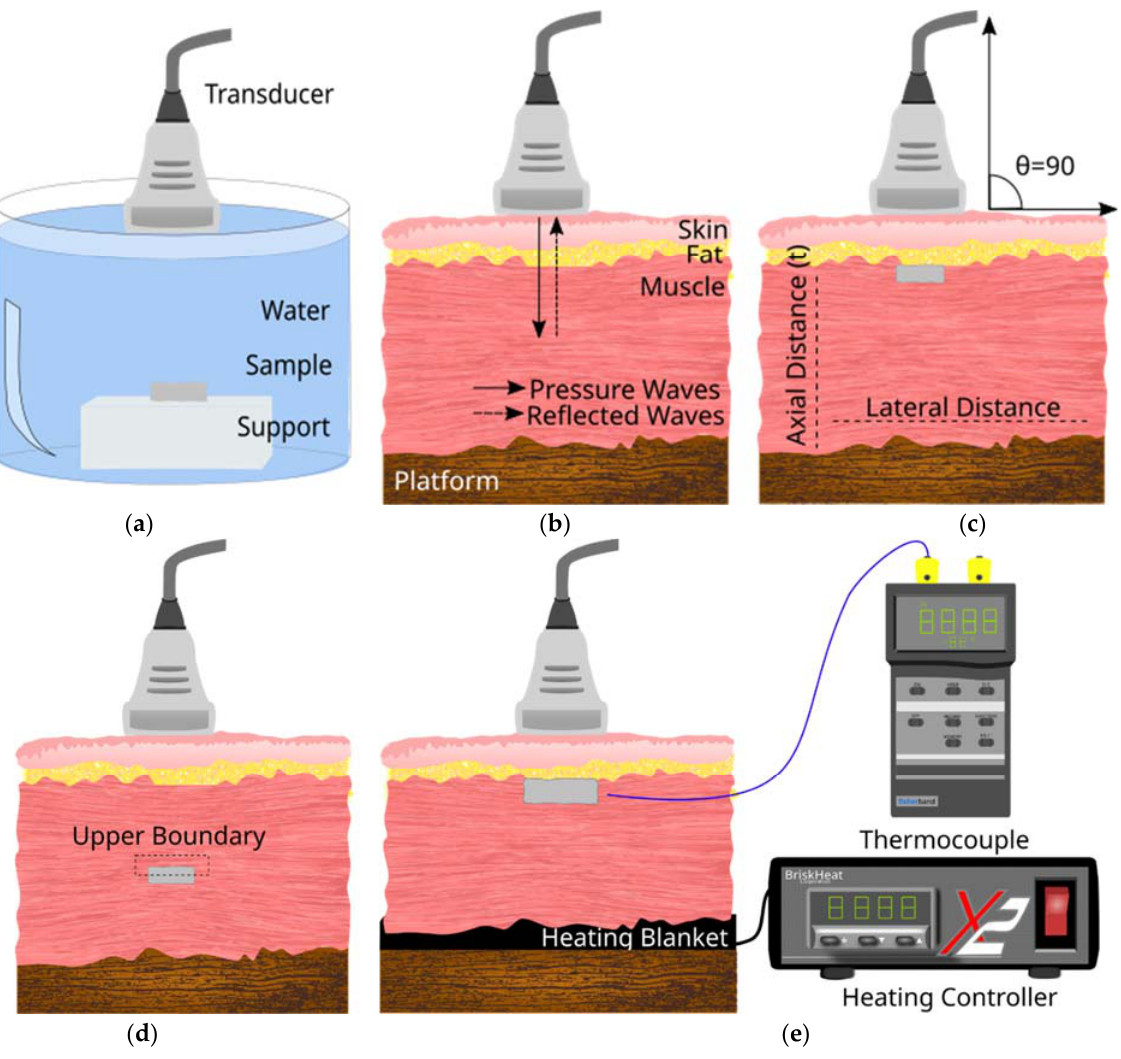
Figure 1. Schematic diagram of the cross-section view of the different configurations used for diagnostic US imaging of aerogel. ( a ) Aerogel samples were tested in an Aq environment by placing them on top of sample support. ( b ) Configuration used to image the tissue without any implants. This served as the baseline for image analysis. Continuous arrows show pressure waves propagating and though the tissue and implant. Discontinuous arrows show reflected pressure waves from the Z difference within the tissue and implant area. ( c ) Configuration where implant insertion is SC ( d ) Configuration where implant insertion is SM. ( e ) Configuration with temperature controlling heating blanket and thermocouple for US imaging at different temperatures The angle of scan was maintained at 90° that corresponds to the 0° in US device settings.